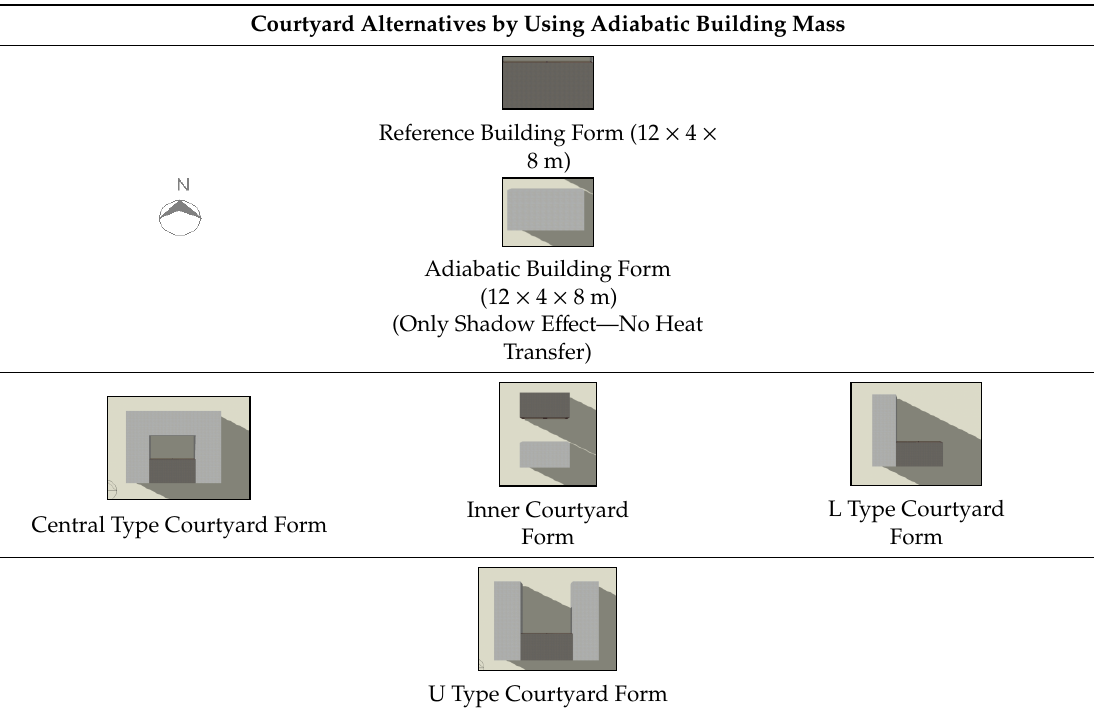
Table 6. Courtyard alternatives by using adiabatic building mass.